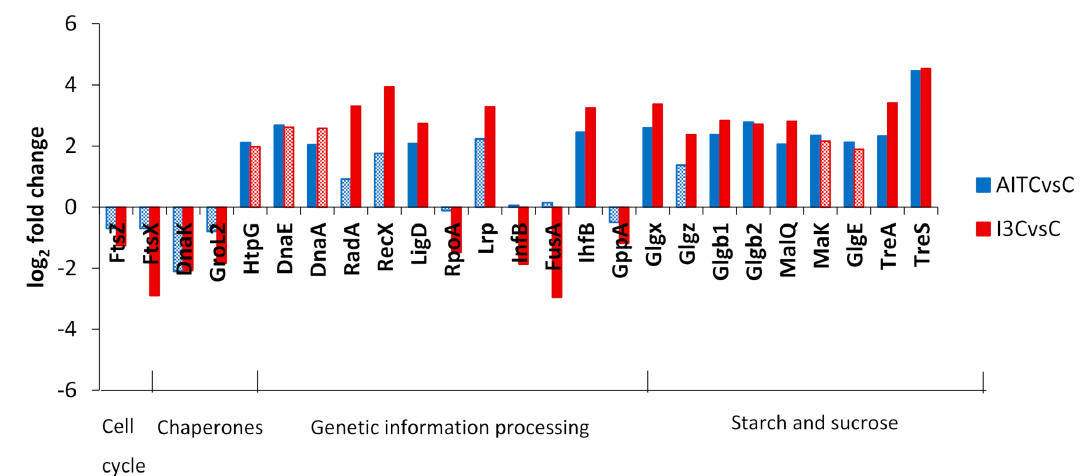
Figure 3. Log 2 fold change of DEGs classified into KEGG categories of cell cycle, chaperones, genetic information processing, and starch and sucrose metabolism in the comparisons of AITC vs. the control and I3C vs. the control. Solid colours of the bars indicate a false discovery rate ≤ 0.05. A description of DEGs is provided in Supplementary Tables S1 and S2. I3C treatment inhibited DEGs related to glycolysis, the TCA cycle, and oxidative phos- phorylation (Figure 4). Both treatments induced DEGs controlling alcohol dehydrogenases. AITC induced DEGs related to the synthesis of acetyl-CoA and its conversion into CO 2 by formate dehydrogenases (Figure